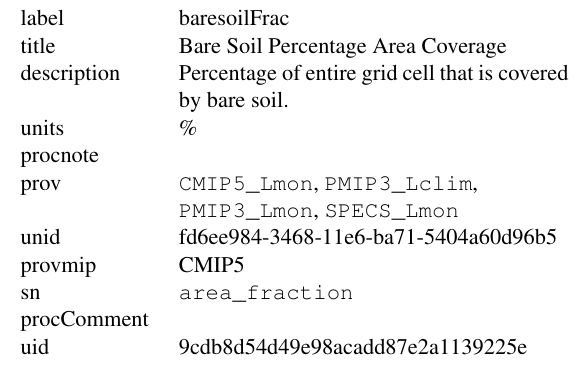
Table 3. Example attributes of the MIP variable record for bare soil percentage area coverage